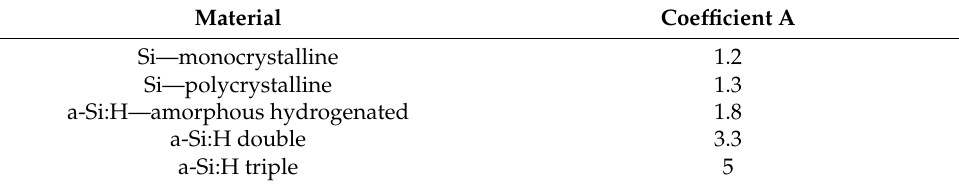
Figure 1. Combined wind-solar power station: (1) Darier rotor; (2) Savonius rotor; (3) supporting structure; (4) photoelectric converters; (5) control cabinet with rechargeable batteries. Table 1. Coefficient of ideality solar cell from material [6].